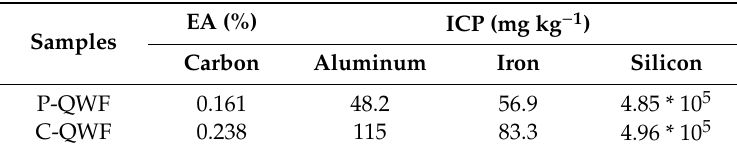
Table 2. The elemental composition of the QWF